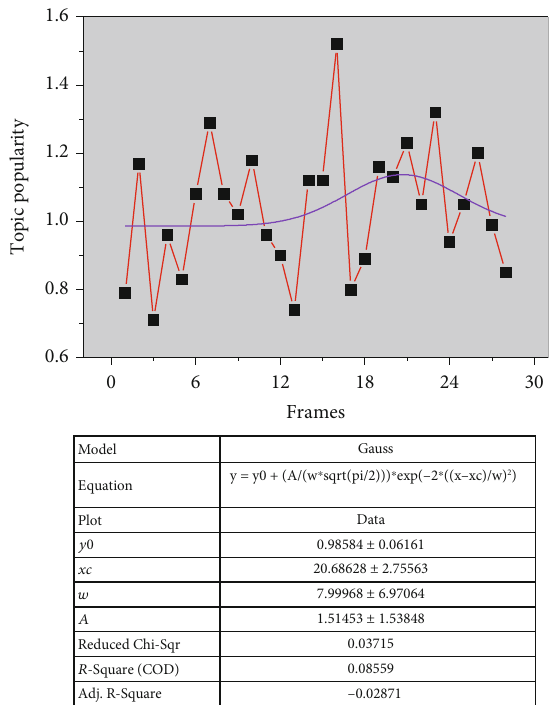
Figure 7: The change of topic popularity before and after the release of the